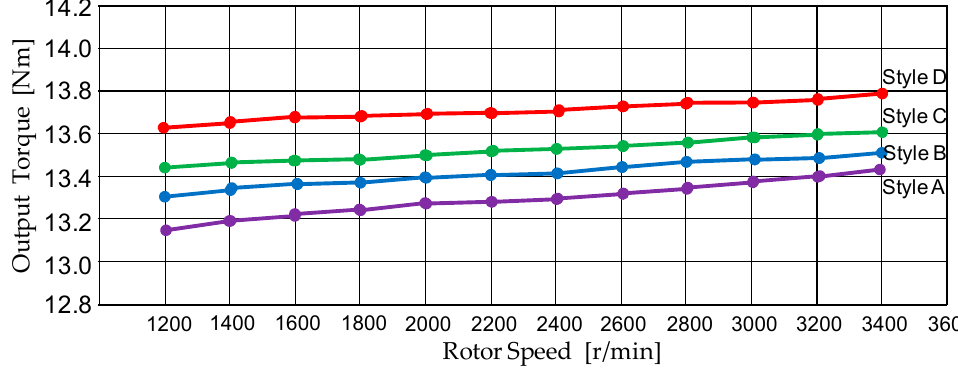
Figure 12. Poly-line graph of output torque for four kinds of SCSCRIMs under several speeds.